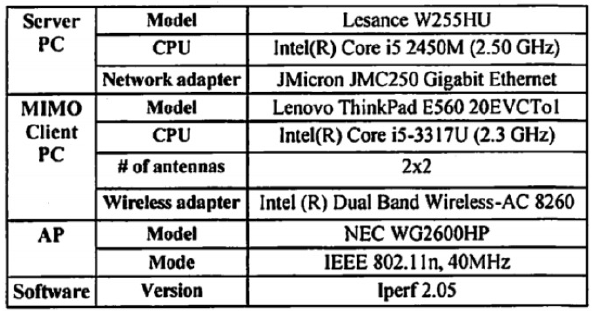
Figure 28. Printed table of scanned table image